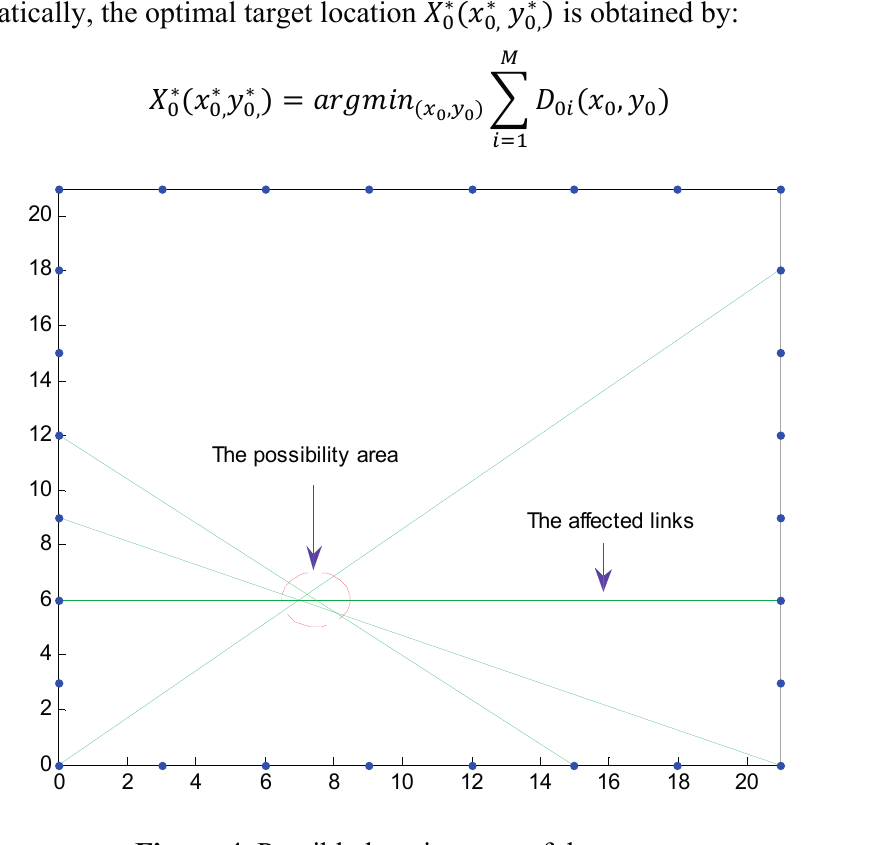
Figure 4. Possible location area of the